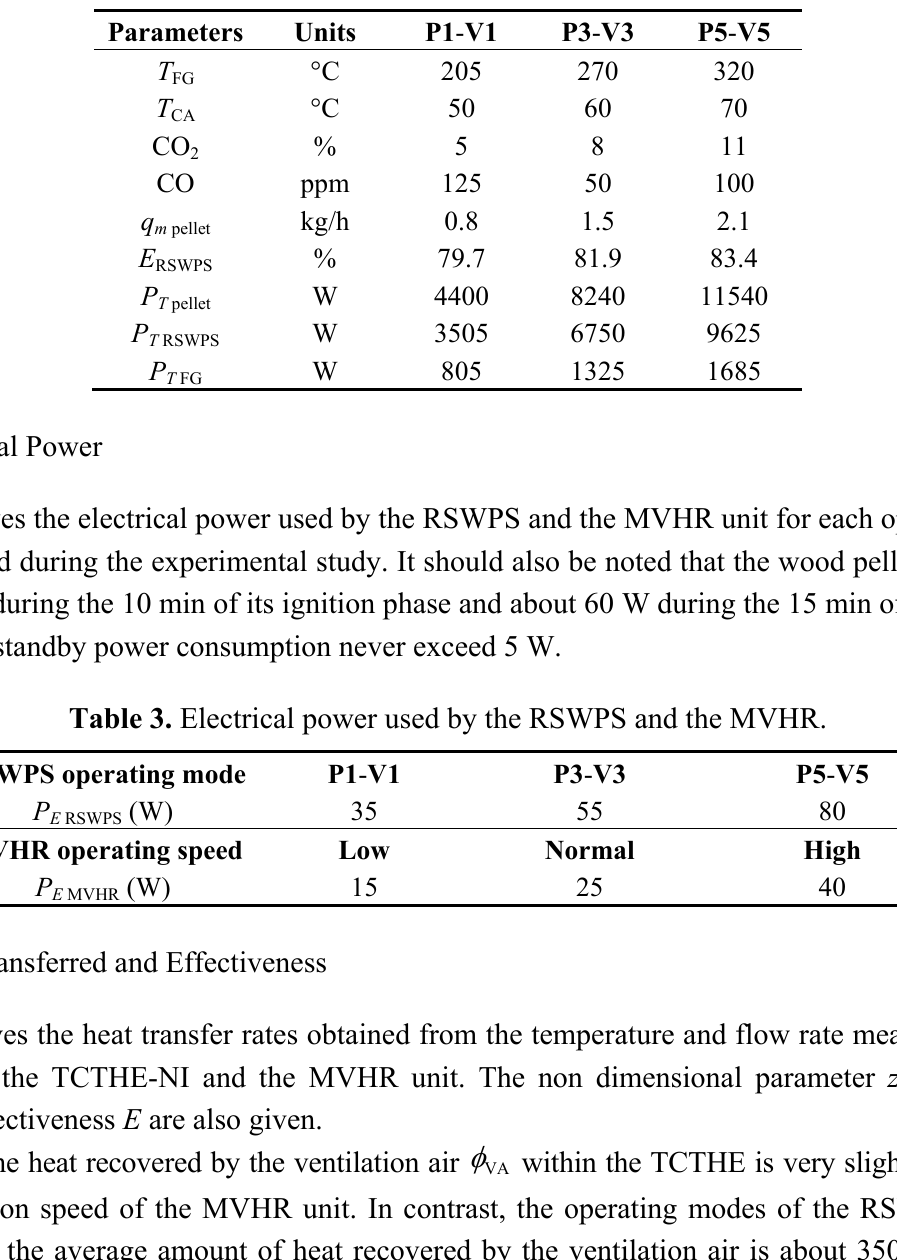
Table 2. Results of the combustion analysis of the RSWPS.